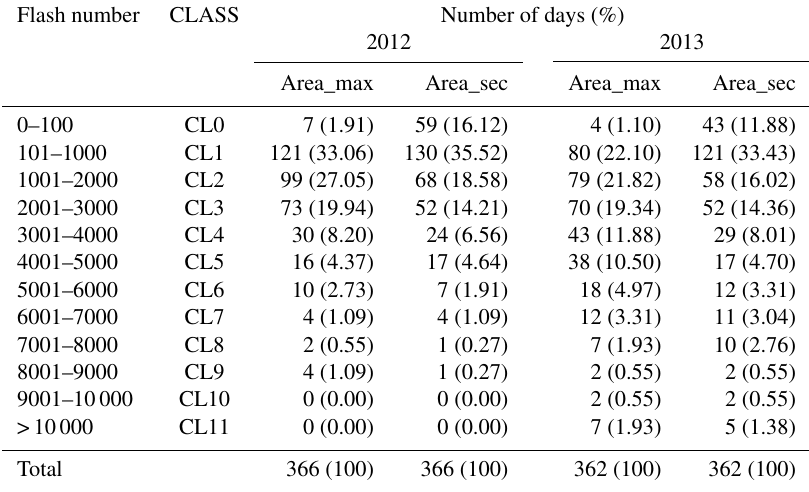
Table 2. Number of days corresponding to lightning classes in the two study areas during the 2012 (366 days) and 2013 (362 days). The percentage is calculated in relation to the total number of days during the year.